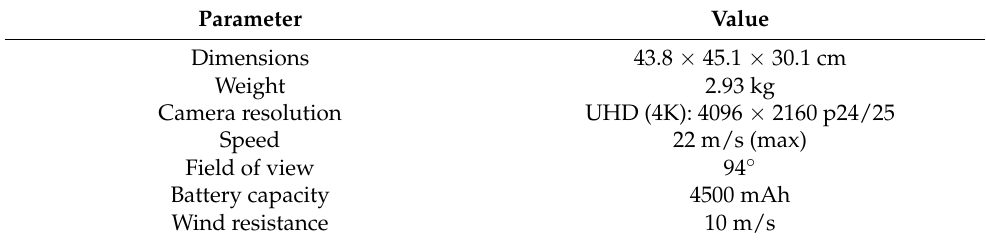
Table 1. UAV technical